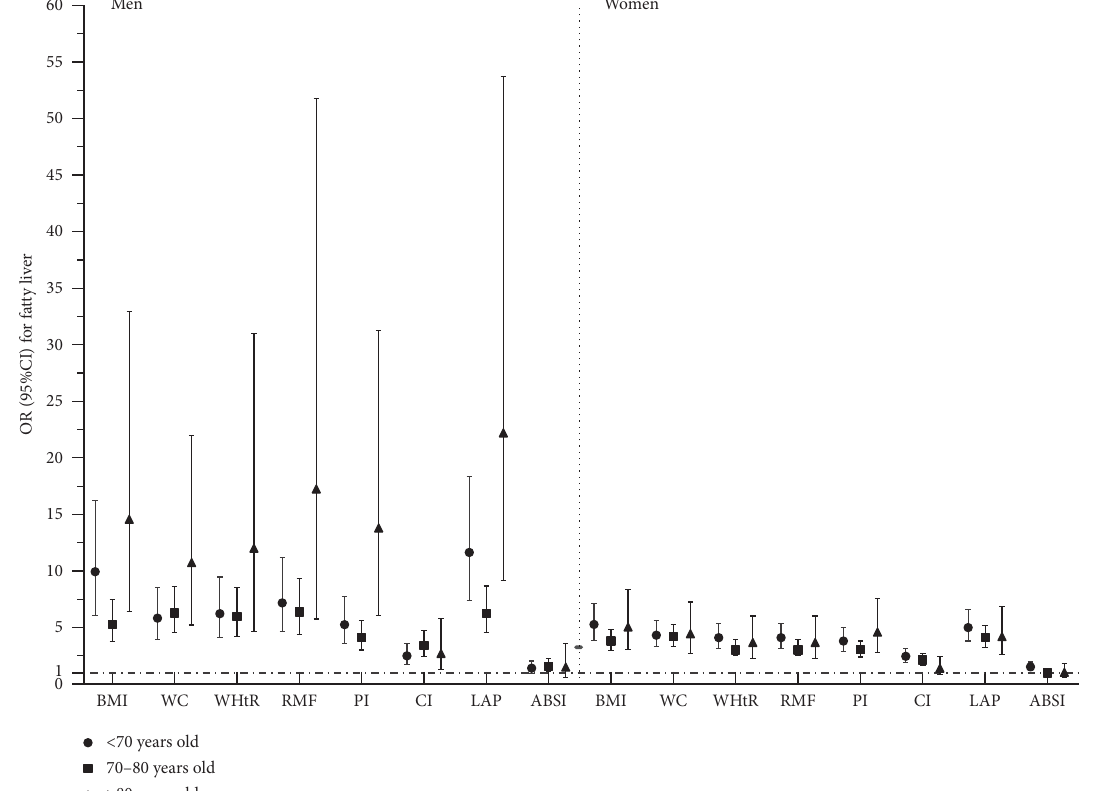
Figure 3: After adjusting for confounding factors, the optimal cut-off value was taken as the demarcation point for the correlation between anthropometric indexes and NAFLD. Confounding variables: age, drinking, physical activity, hypertension, and